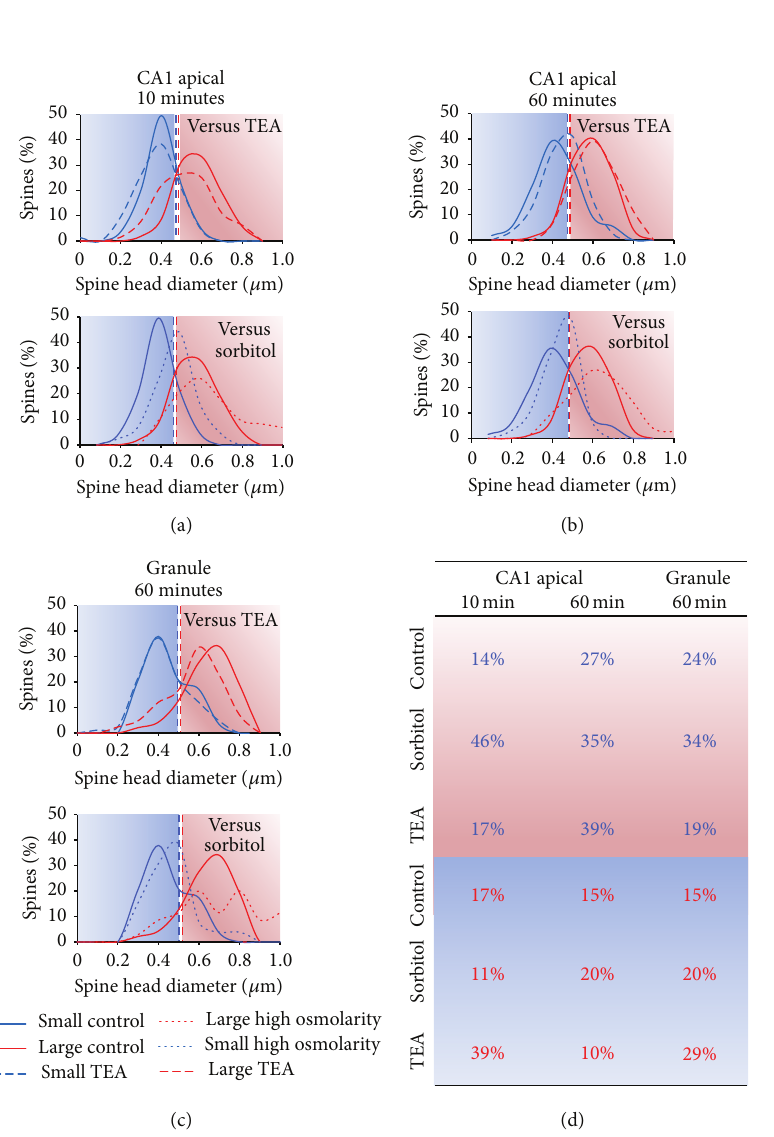
Figure 4: Comparison of small (blue) and large (red) spine head distributions in control versus TEA and control versus sorbitol experiments. ((a), (b)) Distribution of diameters estimated from computed volume measurement of spines in CA1 pyramidal cell apical dendrites (a) 10 and (b) 60 min after application of control (unbroken lines) versus upper panel, TEA (dashed lines), or lower panel, sorbitol (dotted lines), at the same time points. By 60min, large spines (red) have returned to their original size being no different from control spines, whereas the small spines have grown, indicated by the shift of the distribution (blue) to the right. (c) Dentate granule cell distribution of spine diameters at 60 min. Upper panel: the distribution of small spines (blue) is not greatly affected by TEA (dashed lines) whereas the distribution of large spines (red) shifts to the left showing the persistent decrease in spine head diameter compared to controls (unbroken lines). Lower panel: sorbitol (dotted lines) shows no significant change compared to control (unbroken lines). The blue and red backgrounds represent the diameters defined as small or large, respectively, in the initial category definition at − 10min according to mean diameters (vertical dashed lines). (d) Percentages of spines belonging to each size category (as defined at − 10min) that cross the mean into another category at specified time points after application of TEA or sorbitol. Starting category indicated by font colour (blue text, small; red text, large); final category indicated by background colour (blue, small; red, large). Hence, blue writing on a red background indicates a spine that was initially in the small category but that moved across the threshold to the large category by the time point